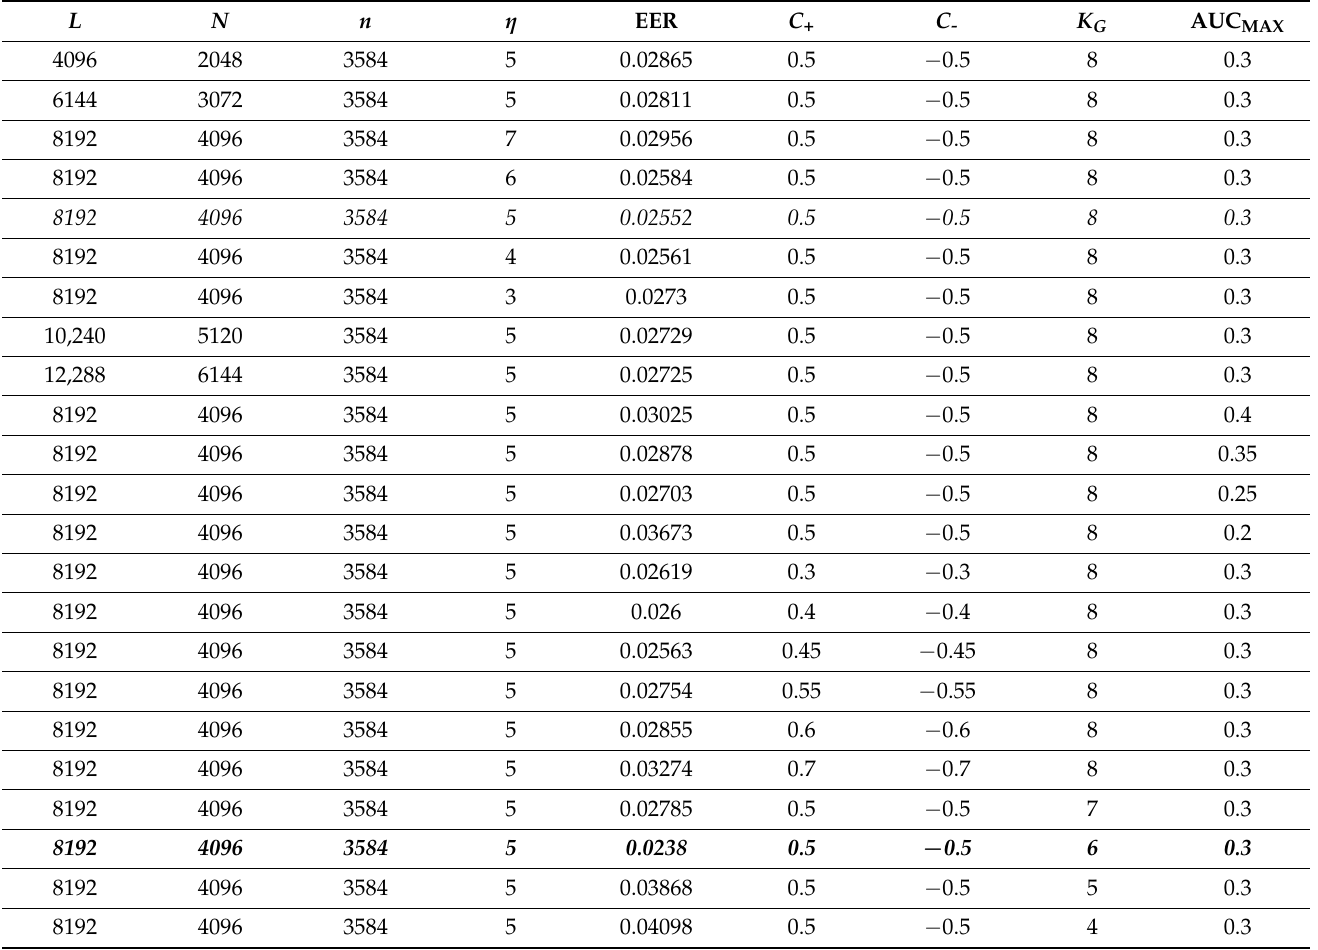
Table 6. Error probabilities of user personality verification with the images of two ears using the combined features of all types of spectra extracted by both